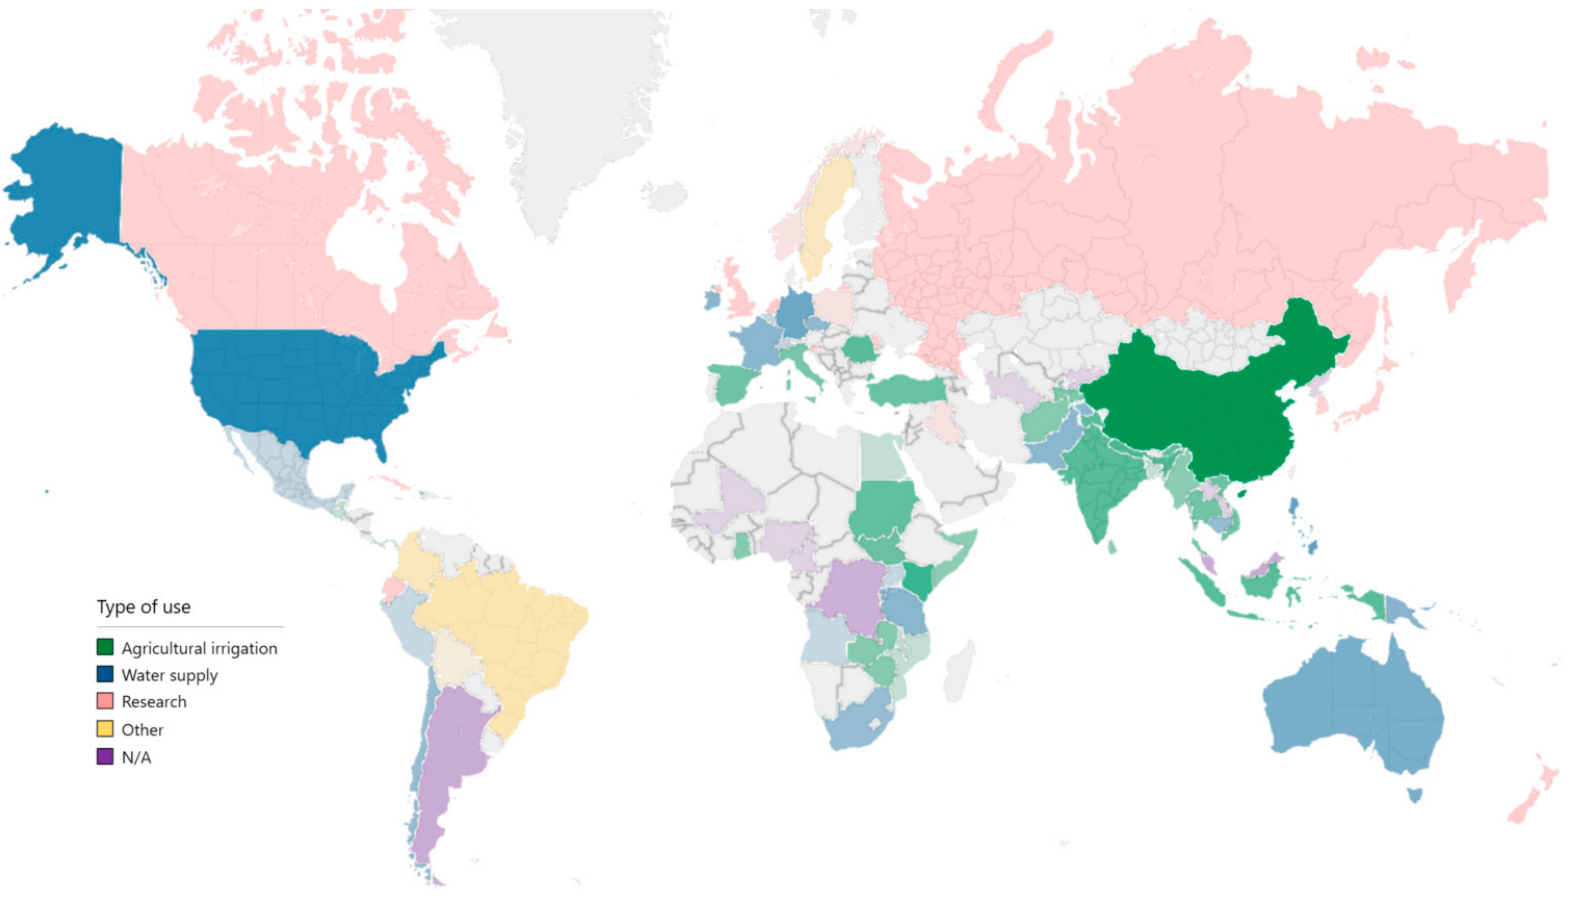
Figure 14. Worldwide mapping of predominant HPP technologies end-uses per country. The intensity of the colors represents, proportionally based on a logarithmic scale, the total number of reported HPP devices serving that end-use. The category “Other” groups the presence of manufacturers, as well as other less-common reported uses: Livestock water supply, aquaculture, land drainage, sewage pumping, landscape irrigation.